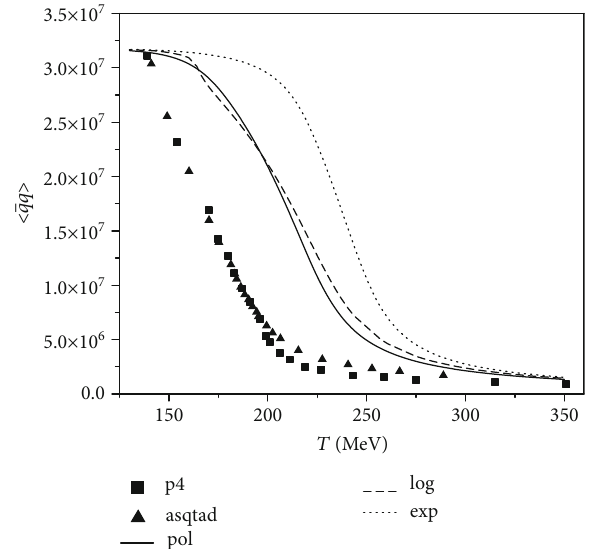
Figure 7: Chiral condensate comparison with